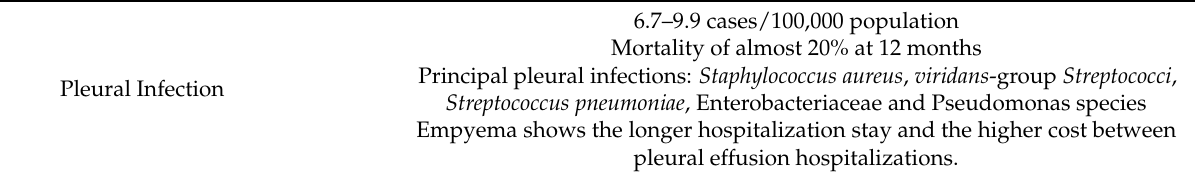
Table 1. Highlights on pleural effusion etiology.